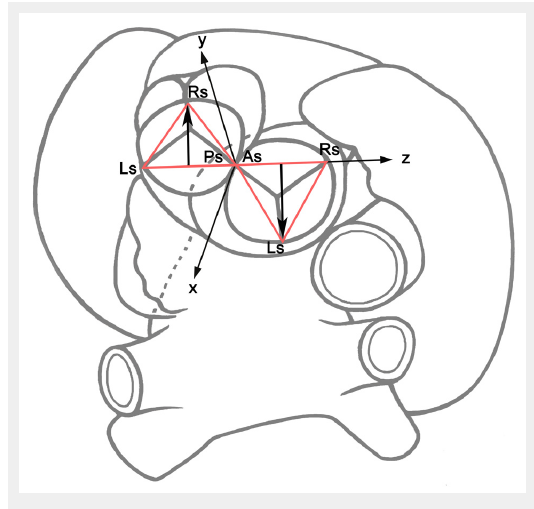
Superior view of the aortic and pulmonary roots. The sinutubular triangles in the aortic (‘ AsRsLs ’) and pulmonary roots (‘ PsLsRs ’) are indicated. The root vectors were positioned parallel to each other in opposite directions. The common frame of reference was positioned with its origin just between the posterior commissure of the pulmonary root and the anterior commissure of the aortic root. The x- axis runs toward the left atrium, the z- axis toward the right auricle, and the y- axis is perpendicular to the ‘ x-z’ plane. Note that the stretch ‘ LsPs ’ of the pulmonary root and the stretch ‘ AsRs’ of the aortic root are positioned along the z-axis. Consequently, the directions of the root vectors are opposite, but